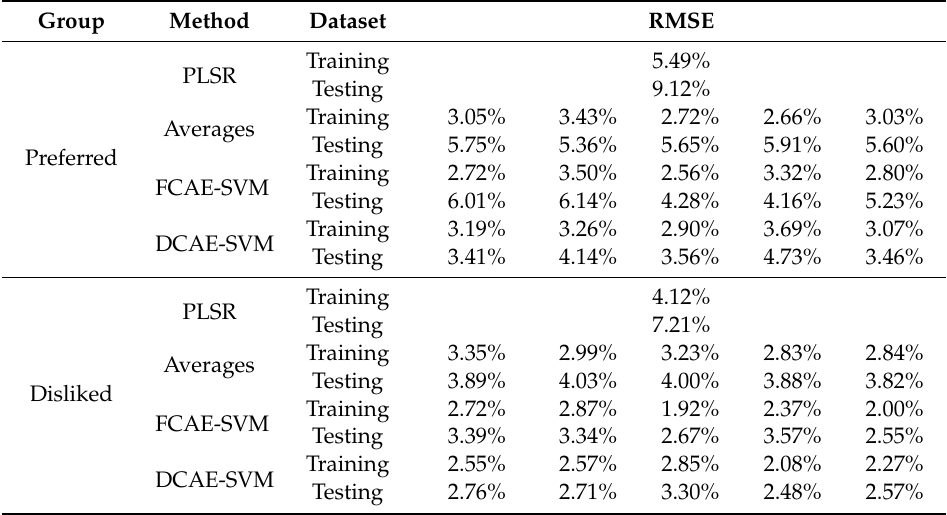
Table 2. Root mean square error (RMSE) of preference predictions based on deep learning and partial least squares regression (PLSR). SVM: support vector